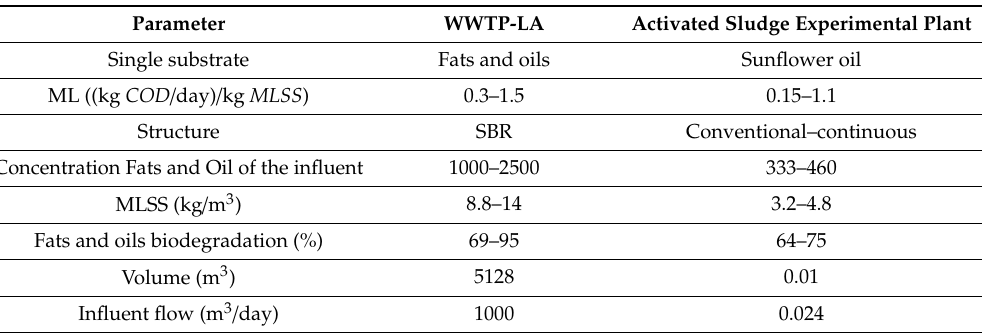
Table 2. Conditions of design and systems